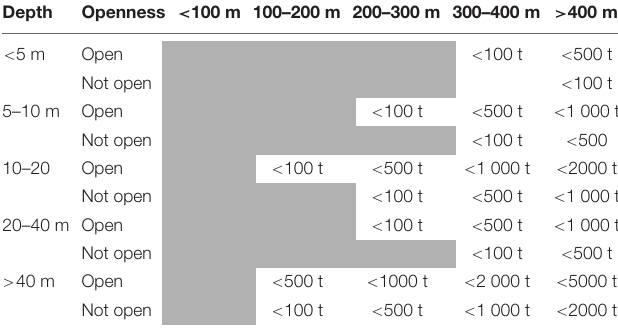
TABLE 2 | A grid that shows the eligibility of fish farming sites, according to the distance from the nearest Posidonia oceanica meadow, the depth, the water movement (openness of the site) and the size of the farm (in wet mass – metric tons – of fish produced per year). Greater distances would of course be welcome.